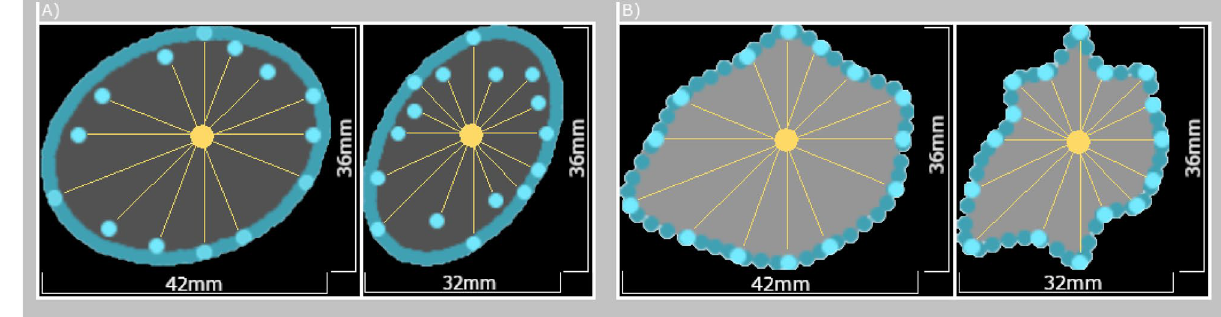
Figure 2. MVEE ( A ) and Spline ( B ) reconstruction for homogeneous phantom number 1. Exemplary shown are slice 44 and 58 along the applicator’s main axis (yellow dot). Visible are the rotated MR images (yellow lines), the data points used as an input (light turquoise) and the corresponding computed outline of the reconstruction (dark turquoise). Note that the number of input points may vary due to outlier